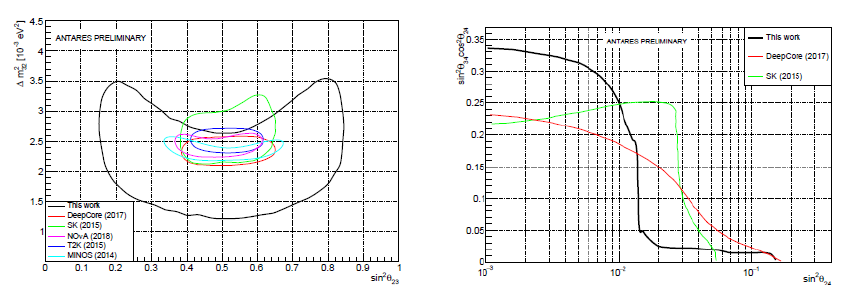
Figure 6 . Left: Contour at 90%CL in the plane of θ 23 and ∆ m 322 using ANTARES data from 2007 to 2016. Right: Constraints on 3+1 models of sterile neutrinos in the parameter space of |U µ4 | 2 = sin 2 θ 24 and |U τ 4 | 2 = sin 2 θ 34 cos 2 θ 24